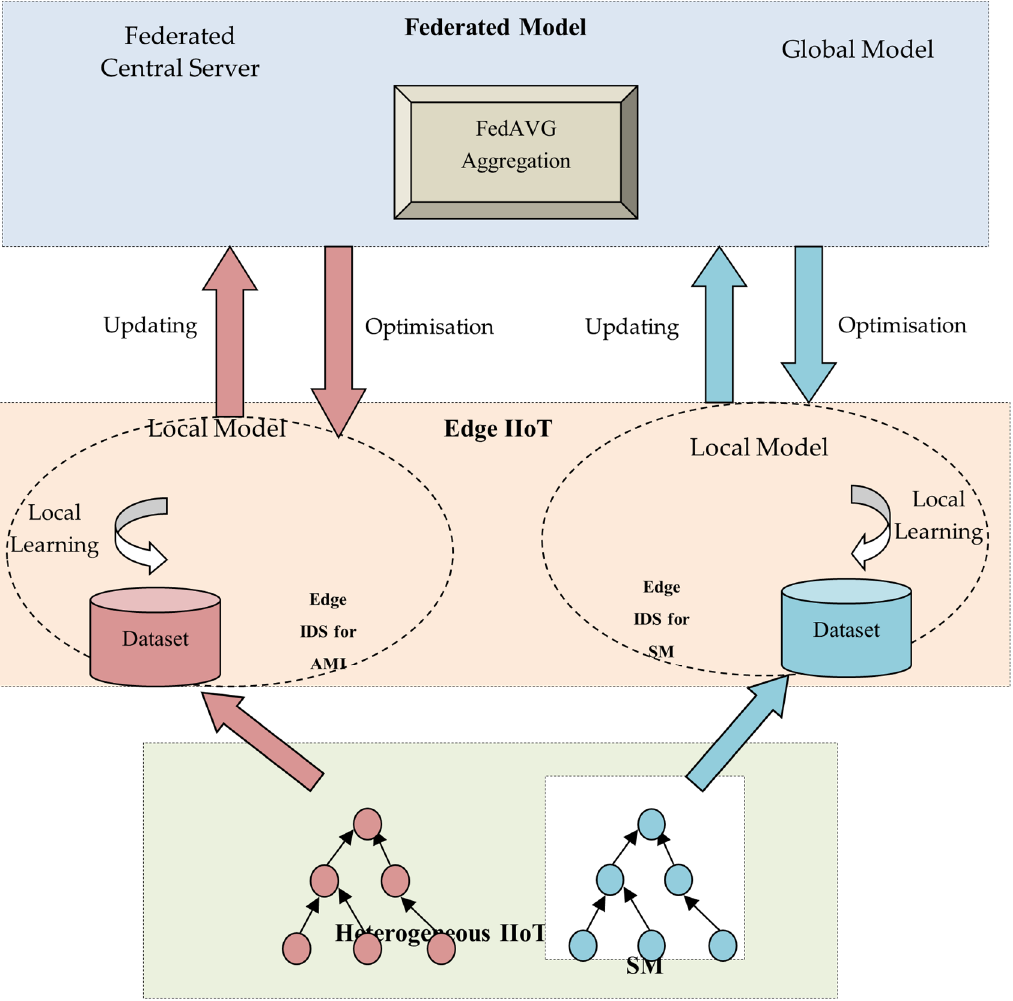
Figure 1. Architecture of heterogeneous IIoT network.